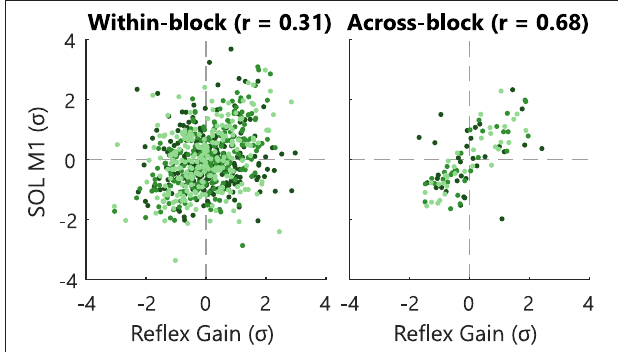
FIGURE 5 | Within- and across-block correlation of reflexive biofeedback variables. Individual participants are visualized with a different color. Correlation analysis for the Impedance group for Session B1–C6 and Blocks 1–3. The within-block correlations were computed using the averaged measures per feedback instance. The across-block correlations were computed using the averaged measures per blocks. Data was Z-score standardized within-block and within-subject, respectively to allow combination of data over sessions and participants. To improve visualization only 10% of all within-block data points are shown. TABLE 2 | Intrinsic motivation inventory (IMI) scores completed after Session C6. Conventional Gaming